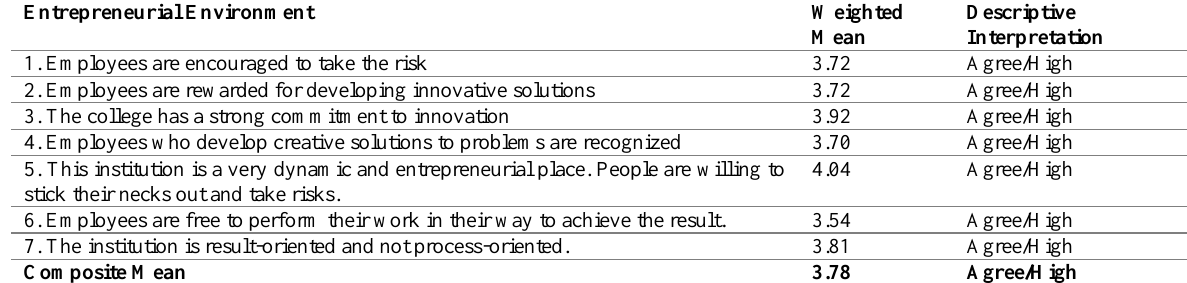
Table 6: Entrepreneurial Environment